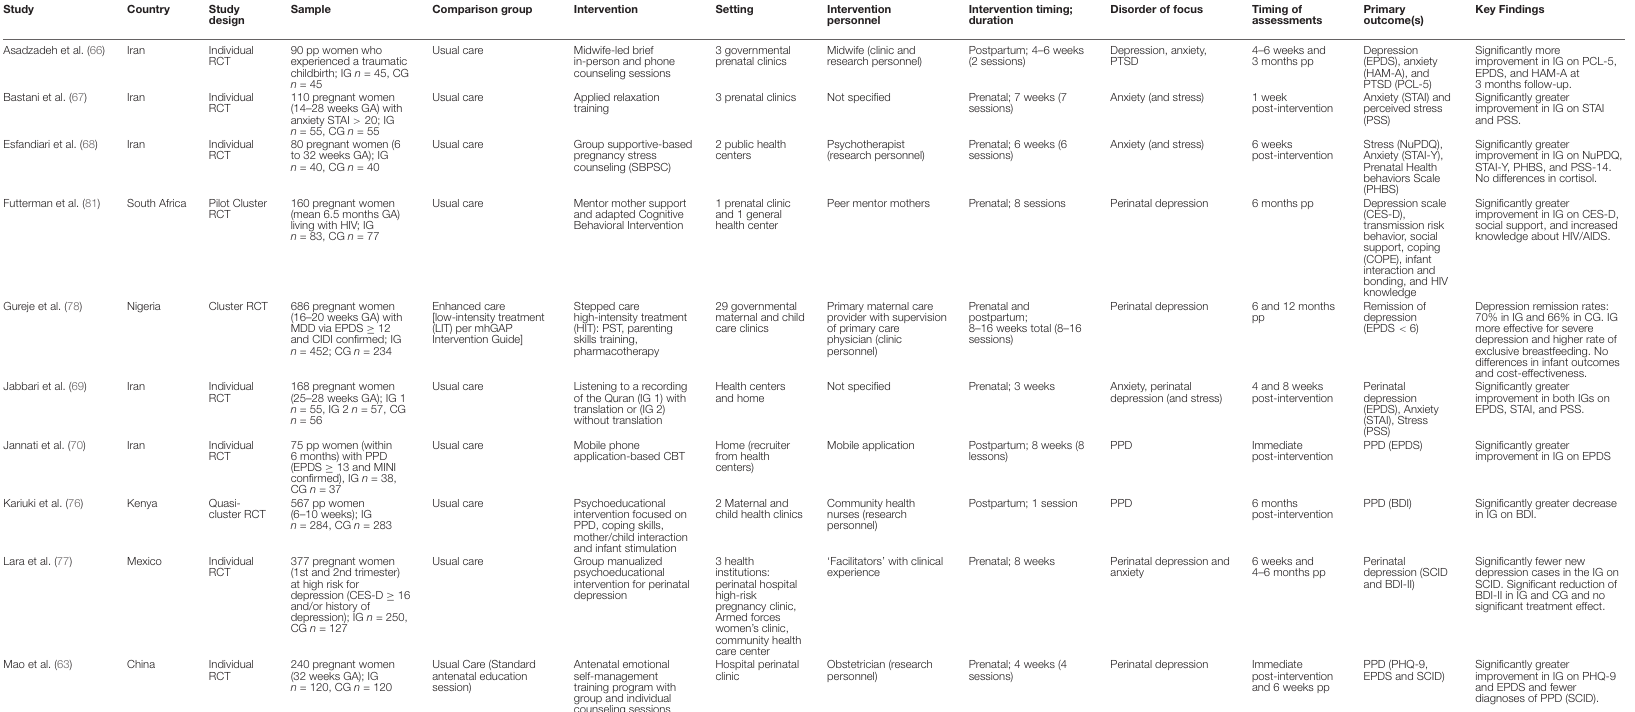
TABLE 1 | Summary of studies selected for systematic